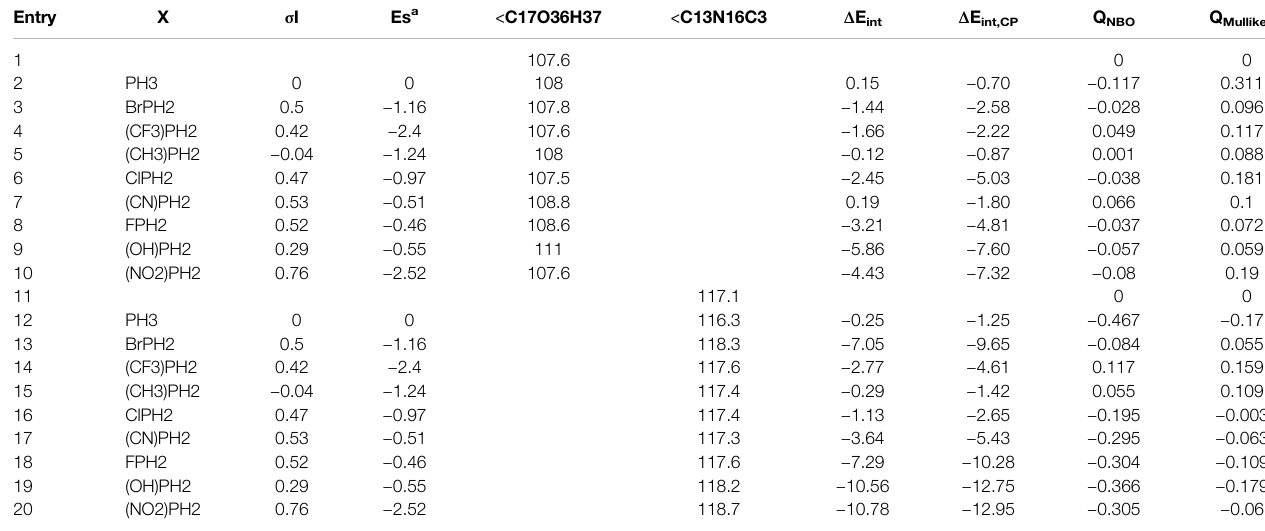
TABLE 4 | Optimized geometric parameters, Δ E int , Δ E int, CP , Q NBO , and Q Mulliken of X-epi-CD1/X-epi-CD2